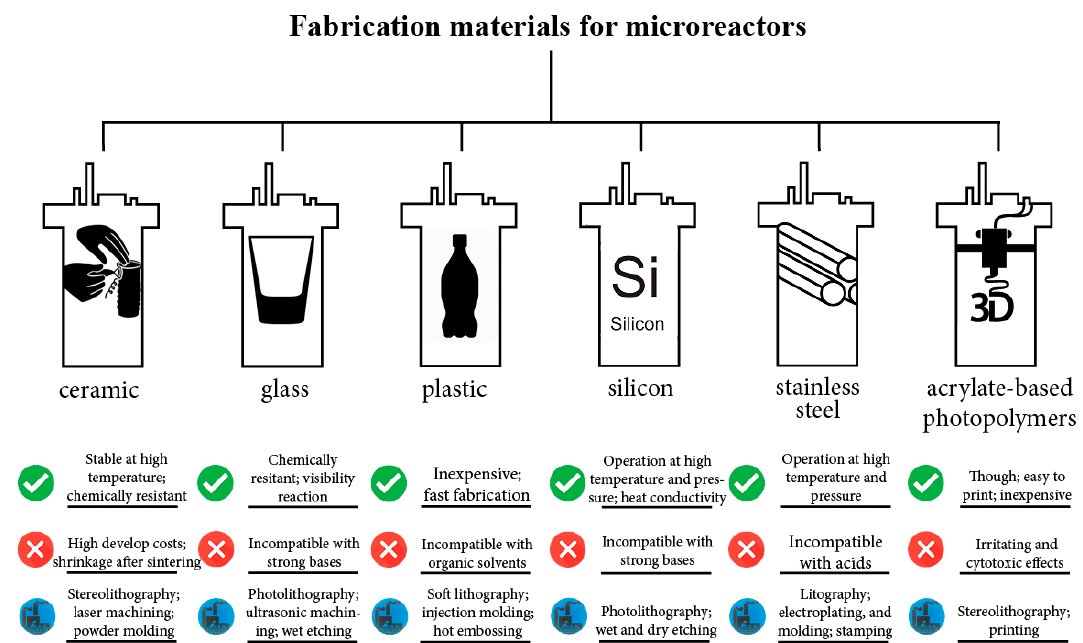
Figure 3. Highlighted features for various miniature reactor fabrication materials [38–48].